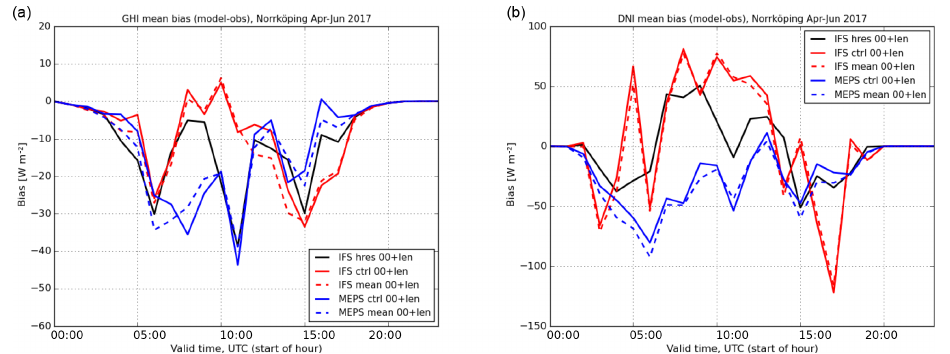
Figure 3. Bias between modelled and measured GHI (left) and DNI (right), Norrköping, April–June 2017.